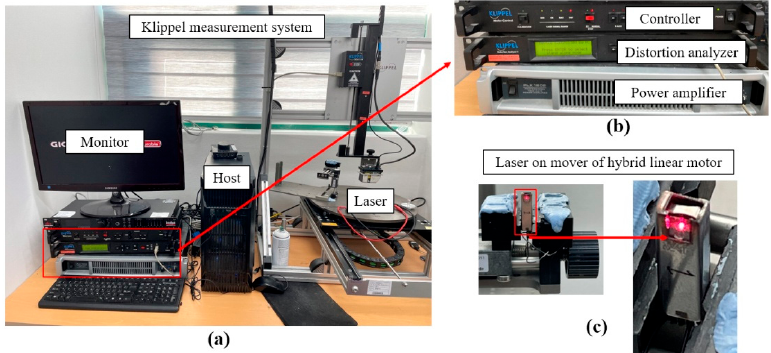
Figure 13. Klippel measure system: ( a ) monitor, host, and laser; ( b ) controller, distortion analyzer, and power amplifier; and ( c ) laser on mover of hybrid linear motor.